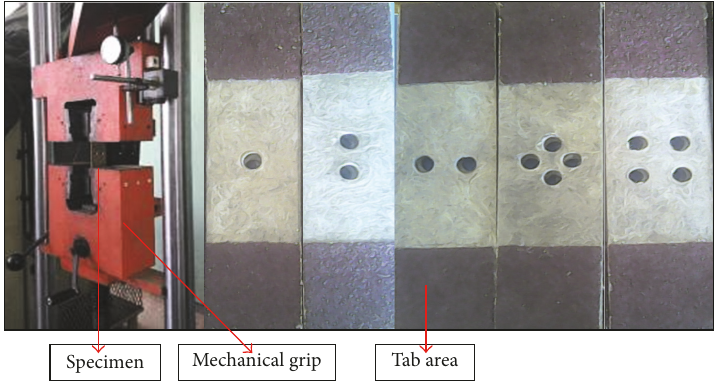
Figure 3: Test setup and lontar fiber-reinforced composite